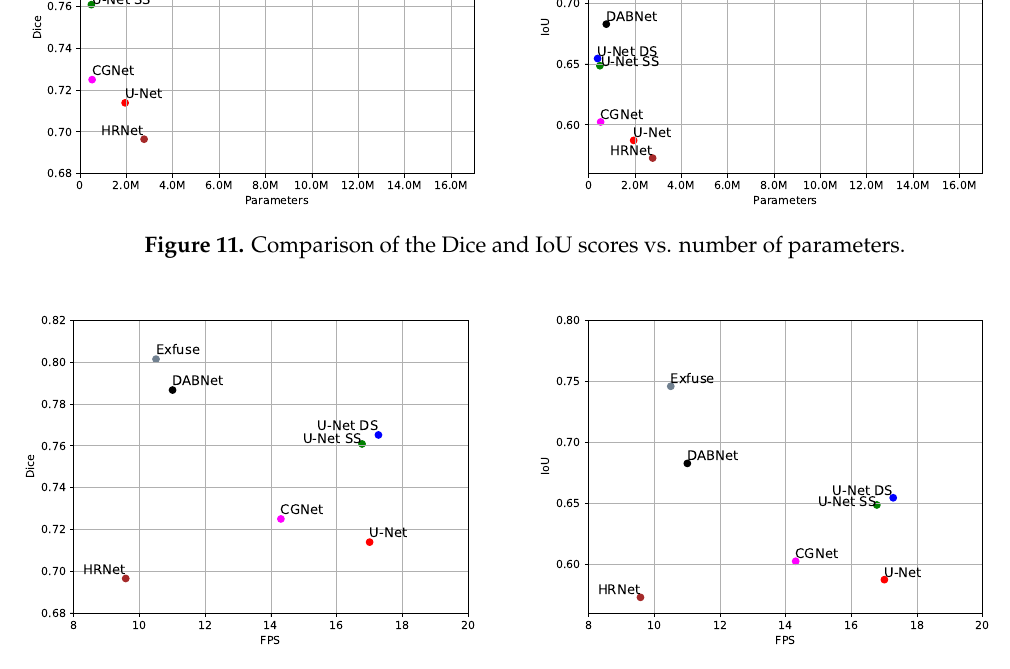
Figure 12. Comparison of the Dice and IoU scores vs. FPS.